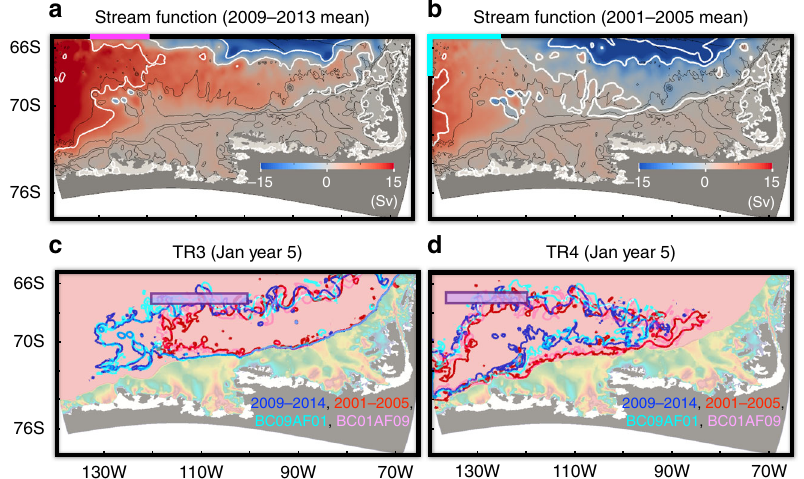
Fig. 3 The 5-year mean stream functions and contours of vertically integrated tracer concentration of 2000 for TR3 and TR4 after 5 years of model simulation. The 5-year mean stream functions for a 2009 – 2013 and b 2001 – 2005 with counters of 20, 10, 0, − 10, and − 20 Sv are shown with bathymetric contours of 500, 1500, 3000, and 4000 m (black contours). Contours of vertically integrated tracer concentration of 2000 for c TR3 and d TR4 after 5 years of model simulation for the CTRL (2009 – 2014), 2001 – 2006, BC09AF01, and BC01AF09 cases are shown. For c , d bathymetry is shown with light colors in the same way as Fig. 1